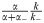
The stationary probability distribution for different ε which shows the transition from fast promoter kinetics, i.e., ε → ∞, to slow promoter kinetics, i.e., ε → 0, in a single unregulated gene.The stationary distribution is bimodal for small ε, i.e. ε ≤ 1, and unimodal for large ε. The deterministic equilibrium coincides with the fast kinetics mode at αα+α−kk−. The slow kinetic limit is calculated via Corollary 4, the fast kinetics limit is a Poisson centered at the deterministic equilibrium, while the remaining curves are computed by evaluating the exact solution given in [64]. The parameters are α− = 0.1, α = 1, k− = 2, k = 20.